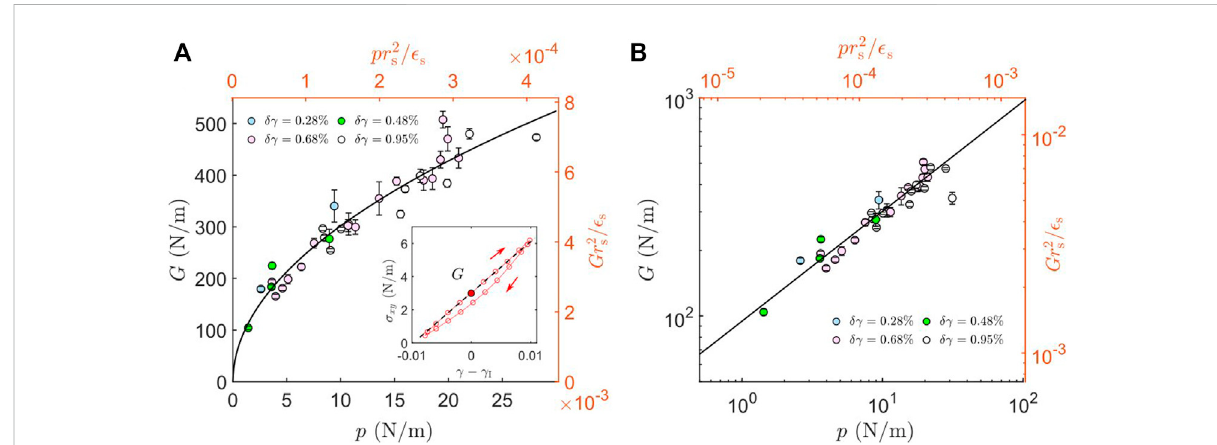
FIGURE 2 The emergent shear modulus of ultrastable states formed by different γ I and δγ as a function of pressure. (A) Insert: an example evolution of shearstress σ xy versus strainundercyclicshearforanultrastablestate.Theshearmodulus G isde fi nedastheslopeoftheforwardbranchofthecurve. Mainpanel:Measurementsoftheshearmodulus G fortheultrastablestatescreatedbycyclicshearwithdifferentstrainamplitude δγ .Eachdatapoint correspondsto anindependent packing. Thebrownaxesshow thecorrespondingdimensionlessvaluesfor pressure andshearmodulus where r ϵ fi t of the form G ∝ p β with β =0.5. (B) Log-log plot of the data as in the main panel of (A) s and s are from Eq. 1. The black curve shows a power-law